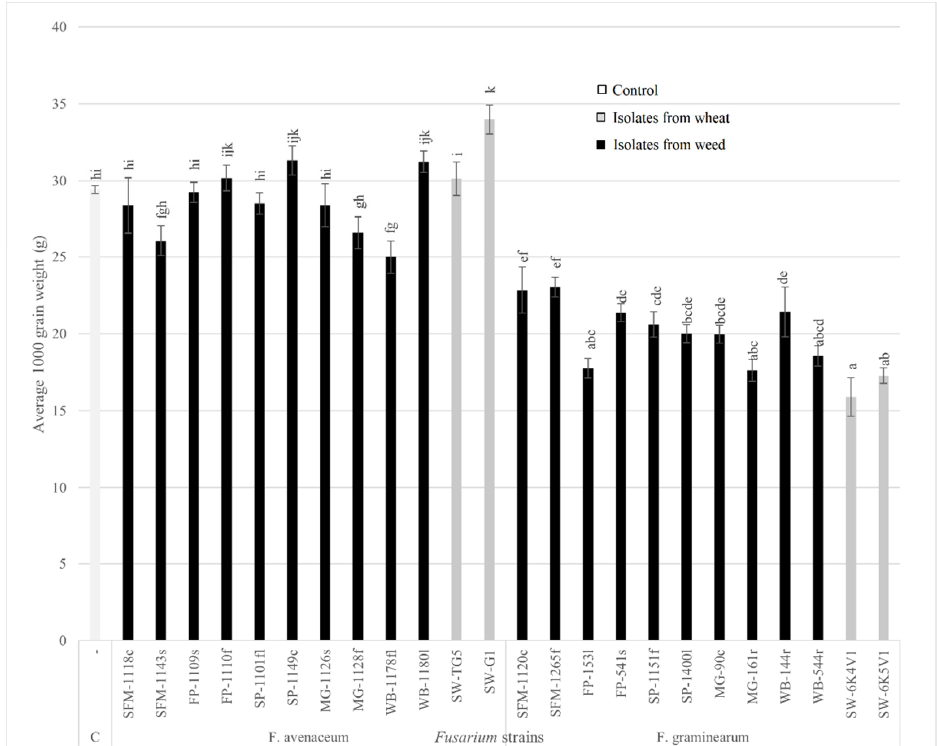
Figure 5. Average 1000-grain weight of spring wheat inoculated with different Fusarium strains isolated from alternative (weeds) and main (wheat) host plants (1000-grain weight was calculated based on the weight and number of grains per 20 heads). (Different letters above bars indicate significant ( p ≤ 0.05) differences (a–k) within the control treatment and Fusarium strain inoculated treatments, and error bars indicate ±SEM. C—water inoculated control).